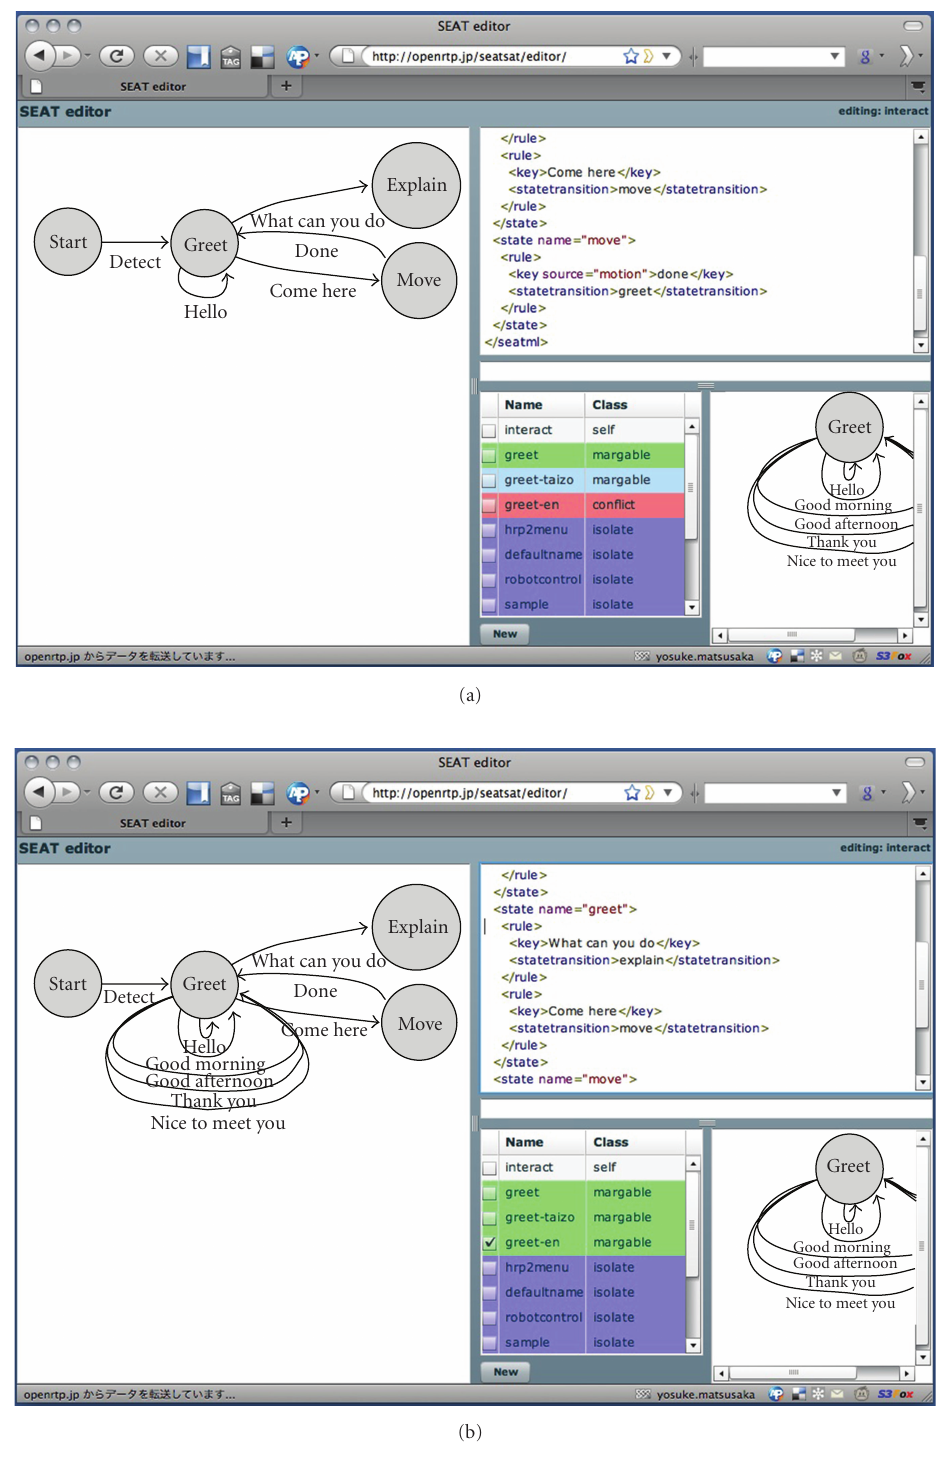
Figure 6: Example of using the web-based interface. (a) Overview of the development interface. Visualization of the state-transition model (left), XML-based editing panel (right top), real-time annotation of existing scripts (right bottom). Editing task script. When the developer types the keyword “Hello”, the existing script from the script database is annotated as “conflict” and suggests reuse. At this step, the system only accepts 3 (“Hello”, “What can you do?”, “Come here”) phrases. (b) When the developer checks the “greet” script, which already